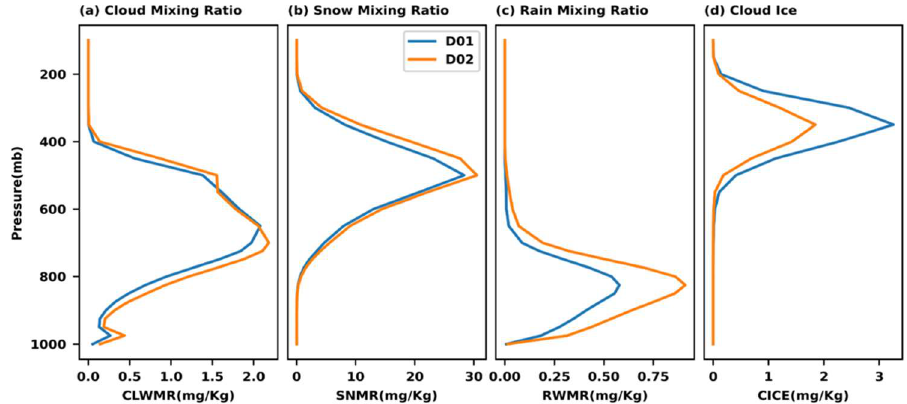
Figure 8. Area-averaged seasonal cloud hydrometeor mixing ratio observed in model simulations.